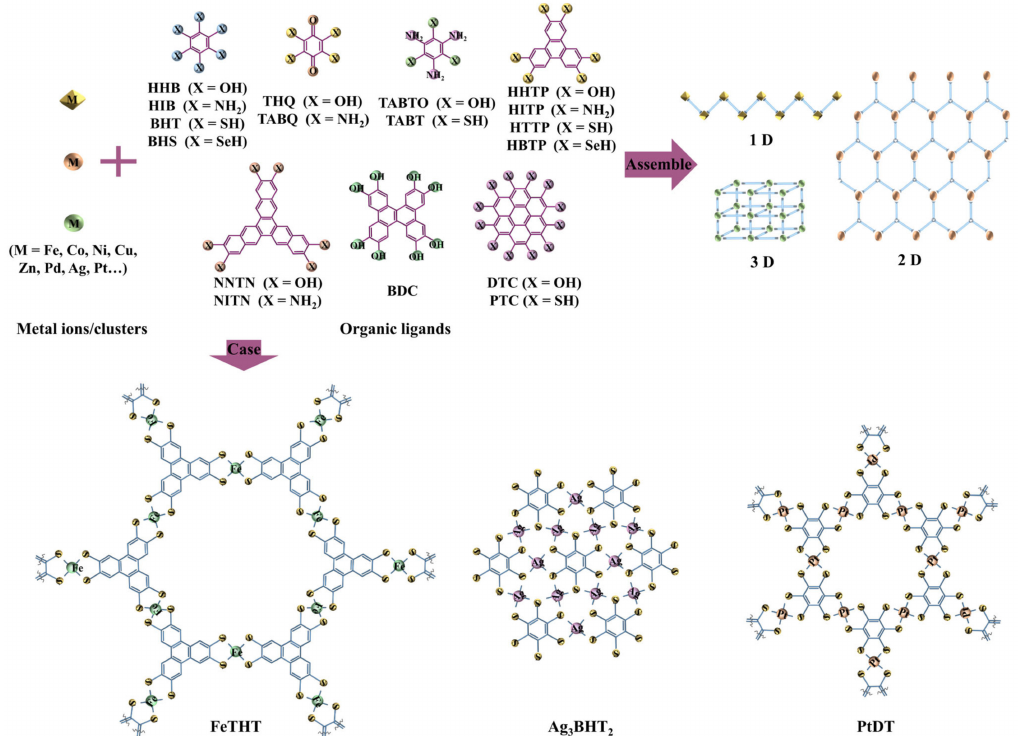
Figure 1. Schematic diagram of MOFs structure and some examples of